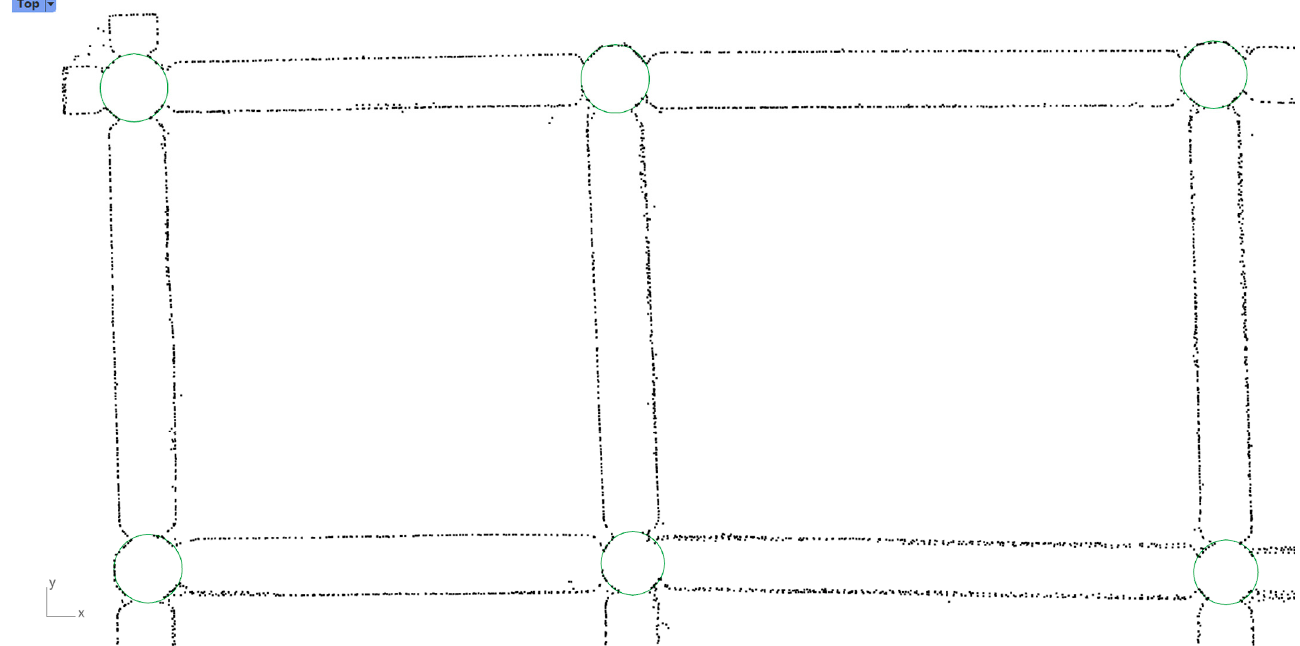
Figure 3. Circles are generated from select points (partial display).